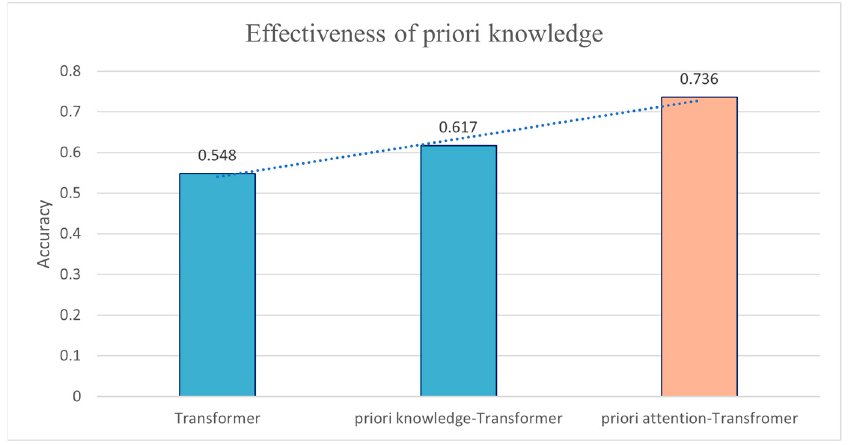
Figure 5. Comparison of a priori knowledge validity.